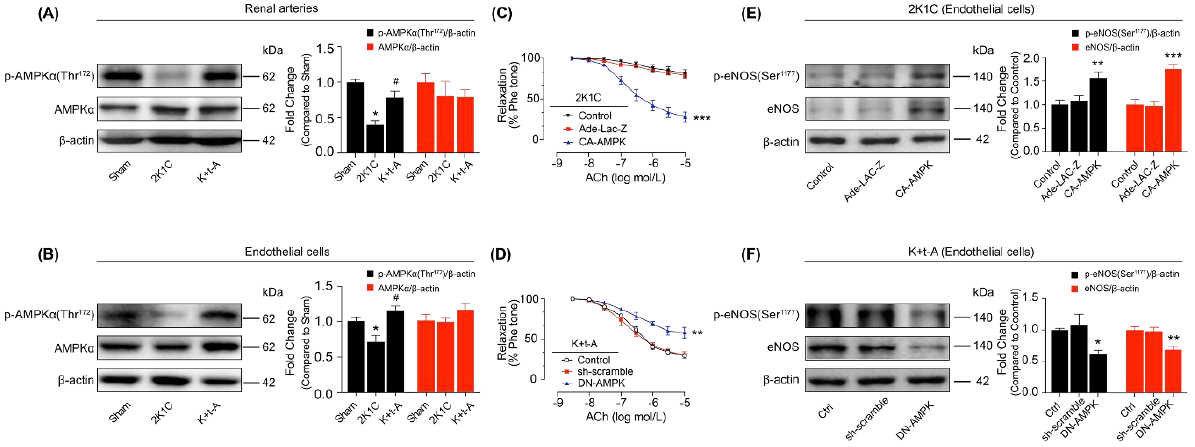
Figure 2. The role of AMPK in the improvement of renal endothelial function by t-AUCB in hypertensive rats. AMPK expressions and phosphorylation in the renal arteries ( A ) and in the endothelial cells ( B ) from Sham, 2K1C, and 2K1C + t-AUCB (K + t-A) groups. The relaxation response to ACh of the 2K1C rat renal arteries, over-expressed with constructively activated AMPK (CA-AMPK) ( C ), and those of 2K1C + t-AUCB rat arteries infected with dominant-negative AMPK (DN-AMPK) ( D ). The effects of CA-AMPK ( E ) or DN-AMPK ( F ) adenovirus on eNOS expressions and phosphorylation in the renal endothelial cells from 2K1C or 2K1C + t-AUCB rats. n = 5 − 8 per group. Data are presented as mean ± SEM. * p < 0.05, ** p < 0.01, *** p < 0.001 vs. Sham or the respective control; # p < 0.05 vs. 2K1C. 3.3. Uncoupling Protein 2 Mediated the Improvement of Endothelial Function, Following AMPK Stimulation in Hypertensive Rats Our previous study revealed that AMPK activation contributed to the amelioration of vascular endothelial dysfunction by upregulating the uncoupling protein 2 (UCP2) in spontaneously hypertensive rats (SHR) [28]. First, we also announced that the reduced UCP2 expression was raised by t-AUCB in the 2K1C rat renal arteries (Figure 3A) and renal endothelial cells (Figure 3B). The over-expression of UCP2 recovered the renal EDRs (Figure 3C) and increased eNOS expression and phosphorylation (Figure 3E) in renal endothelial cells from hypertensive rats. Moreover, the sh-UCP2 adenovirus suppressed these improvements by t-AUCB (Figure 3D,F). In 2K1C hypertensive rat renal endothelial cells, AMPK over-expression increased the UCP2 level, but UCP2 over-expression did not affect AMPK expression or activity (Figure S2A). In the endothelial cells from t-AUCB- treated hypertensive rats, the DN-AMPK adenovirus induced a reduction in UCP2 expression; however, the sh-UCP2 adenovirus did not affect AMPK expression or phosphorylation (Figure S2B). Based on the above observations, we concluded that t- AUCB resulted in the improvement of endothelial function through the activation of the AMPK/UCP2 cascade.